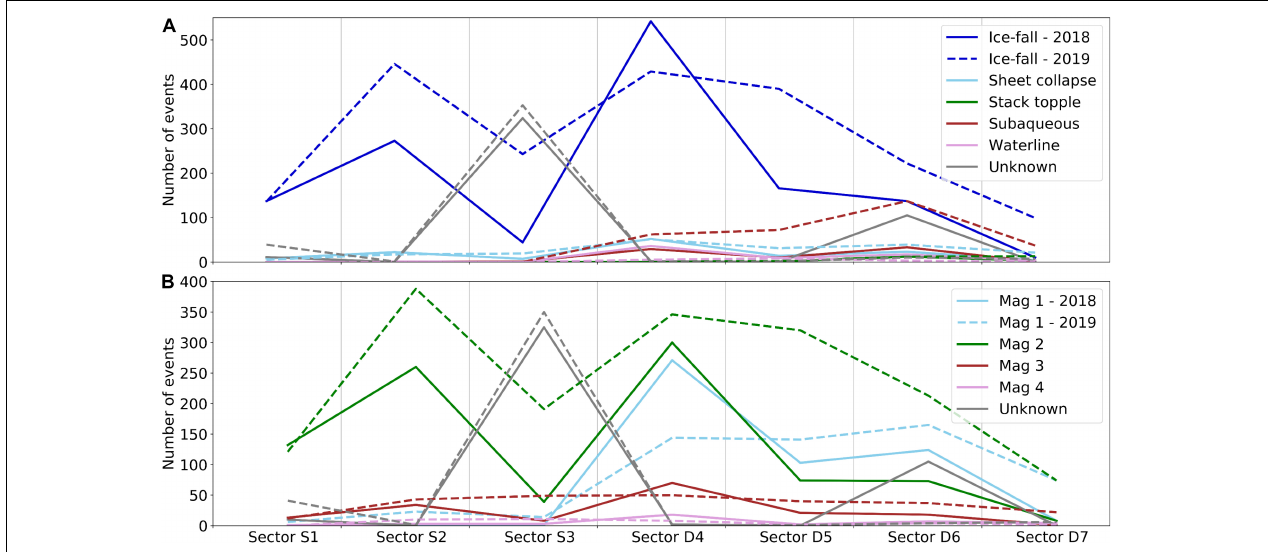
FIGURE 7 | Number of events detected in the sTLC images (10s interval) for each calving front sector as defined in Figure 3 over a 4 day period in July 2018 (solid lines) and over a 6 day period in August 2019 (dashed lines), (A) for the calving types and (B) for the calving